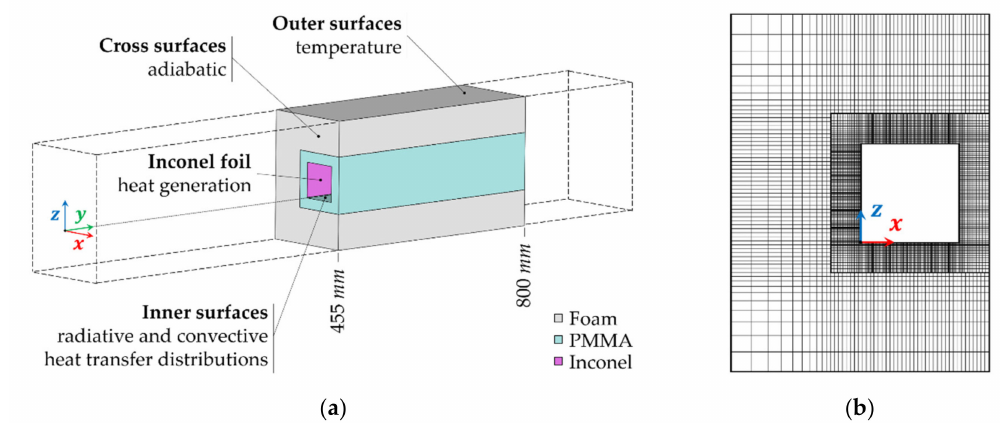
Figure 4. Conductive numerical model: ( a ) domains and boundary conditions; ( b ) cross-section view of the computational